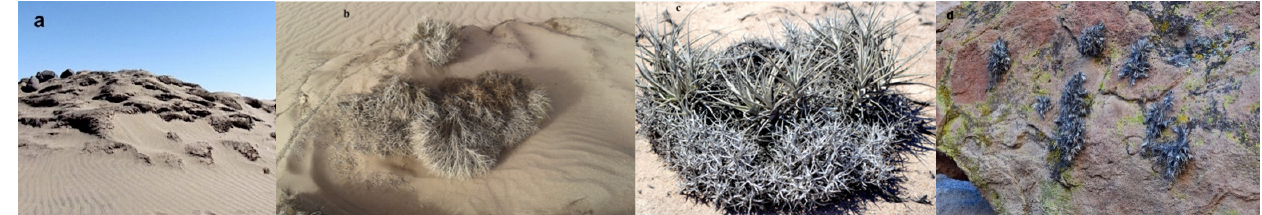
Figure 1. Tillandsia in situ. ( a , b ). Tillandsia landbeckii mounds (Pampa Camarones 1010 m). ( c ). Tillandsia marconae growing next to T. landbeckii (Pampa Dos Cruces 1000 m). ( d ). Tillandsia virescens , saxicolous species, hanging from a rock (Pukara de Copaquilla 3000 m).